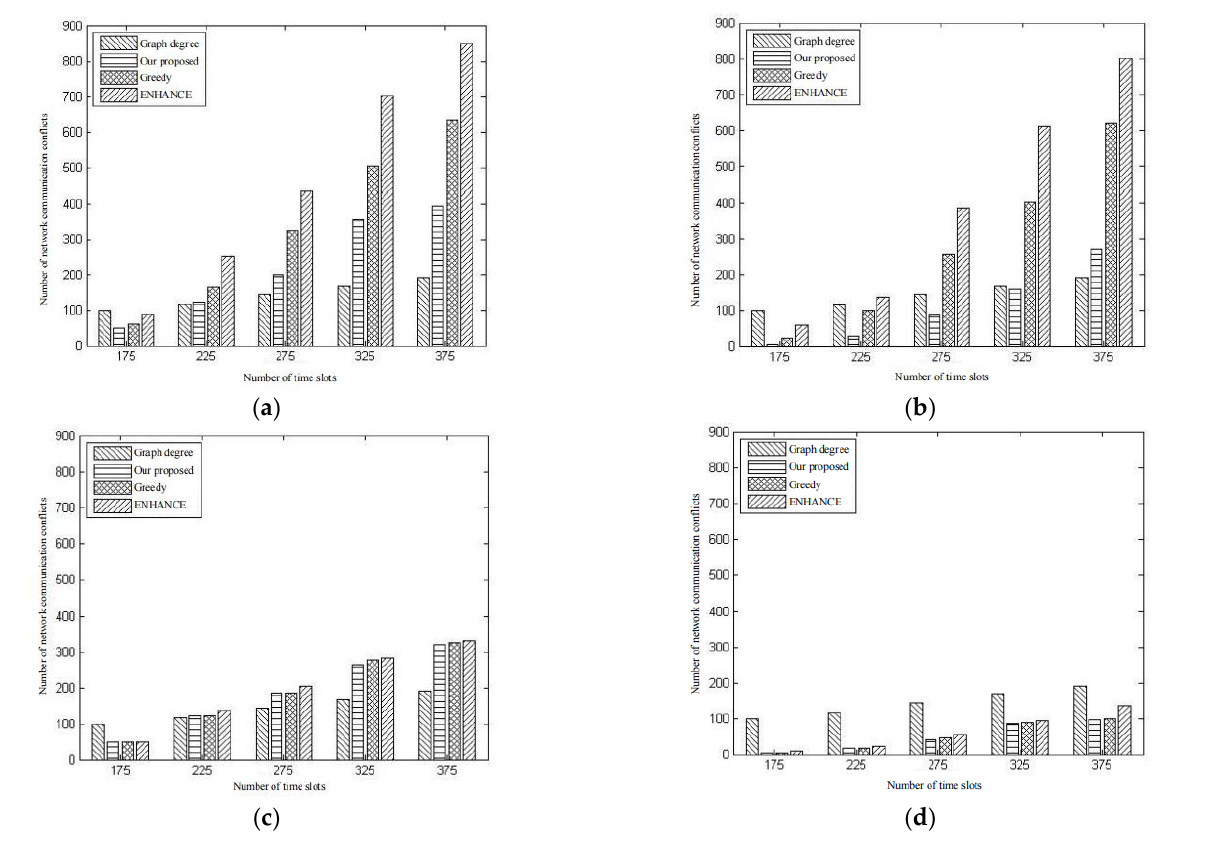
Figure 11. Effect of routing tree’s degree on scheduling algorithm. ( a ) Degree is ∆ G /2 (channel is 3), ( b ) Degree is ∆ G /4 (channel is 3), ( c ) Degree is ∆ G /2 (channel is 12), ( d ) Degree is ∆ G /4 (channel is 12).